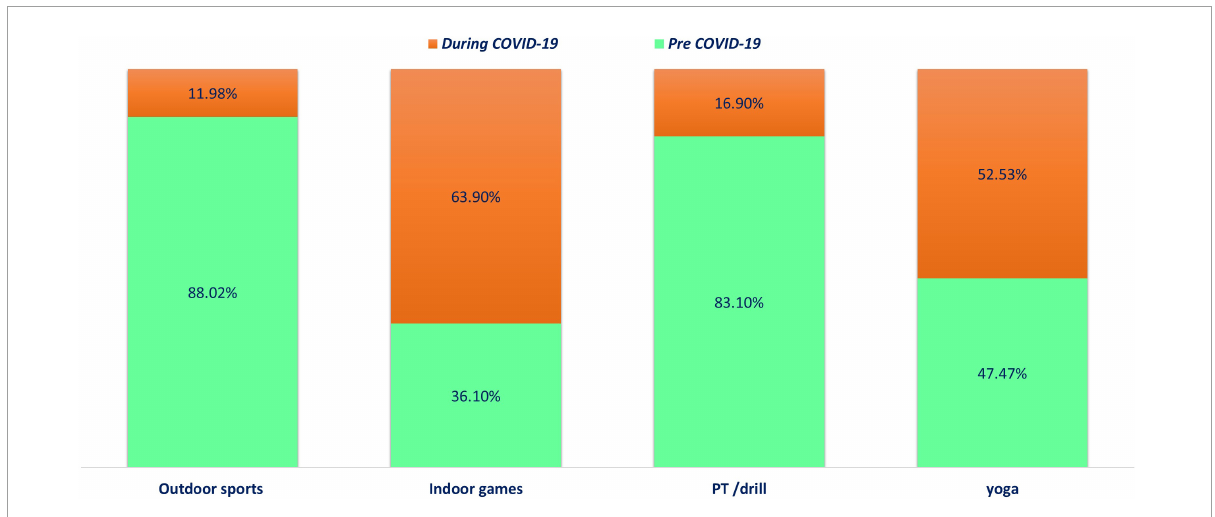
FIGURE2 Activities performed in physical education/PT period in school pre and during COVID-19.